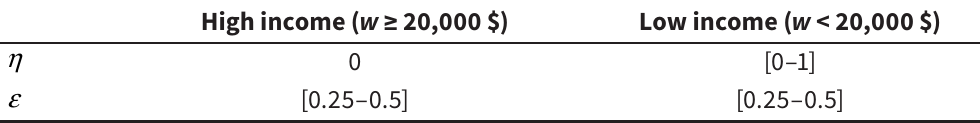
The table indicates a range of possible elasticities for the United